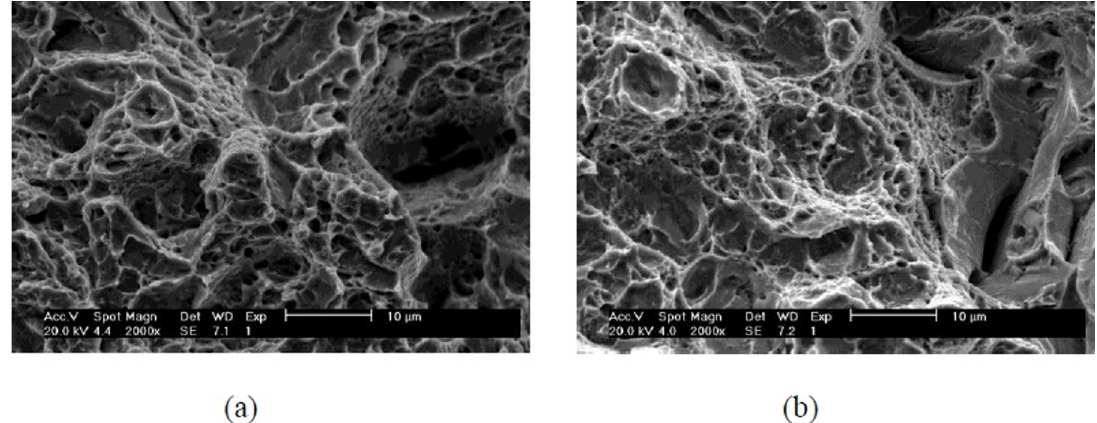
Figure 9. Scanning electron micrograph (SEM) of microcrack being initiated during charpy impact testing of specimen having 49% lower bainite.